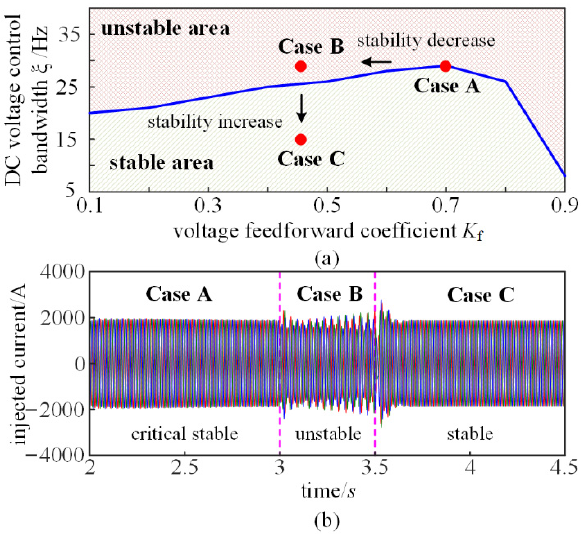
Figure 9. ( a ) The curve of DC voltage controller bandwidth changing with voltage feedforward coefficient; ( b ) Waveform of injected current under different voltage feedforward coefficient and DC voltage controller bandwidths.